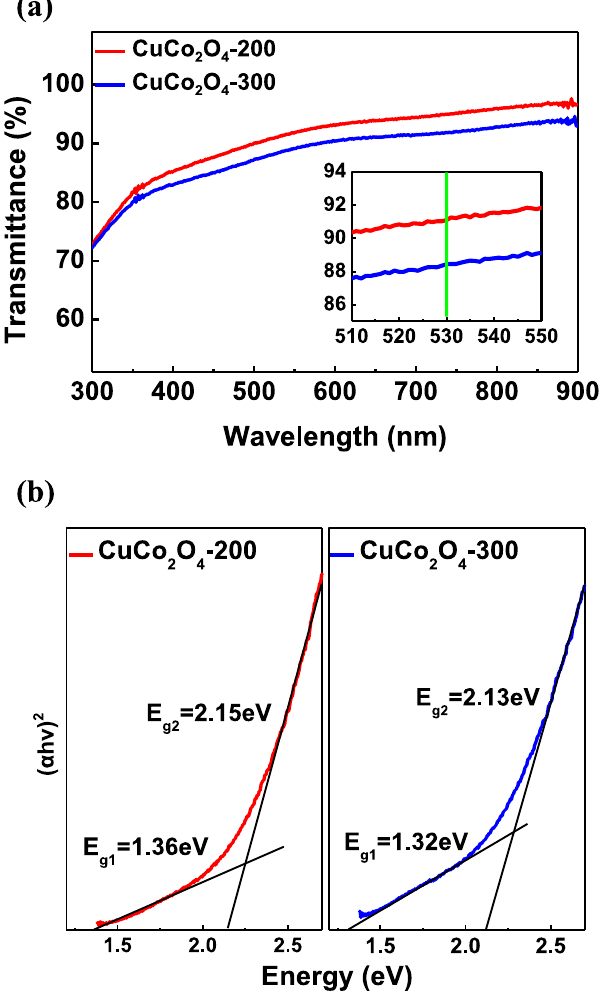
Figure 3. ( a ) Transmittance of CuCo 2 O 4 -200 and -300 thin film. ( b ) CuCo 2 O 4 -200 and -300 optical bandgap.